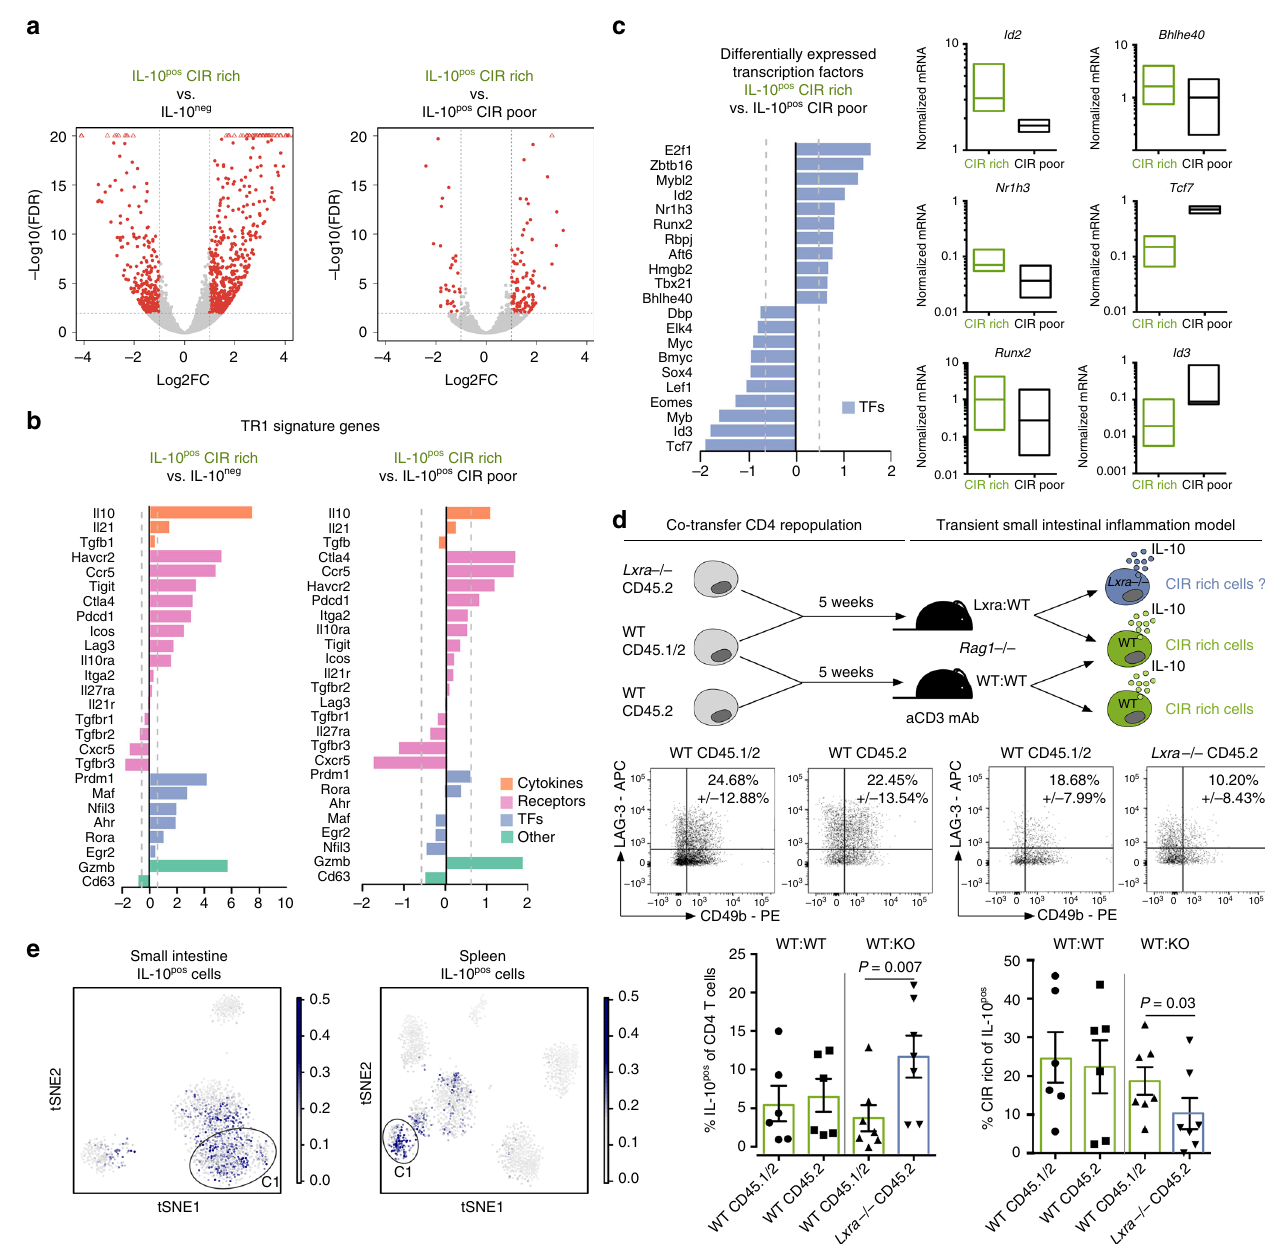
Fig. 5 CIR rich CD4 + T cells have a distinct transcriptional program. a Volcano plots of bulk RNA sequencing data of indicated populations (IL-10 pos CIR rich n = 2; IL-10 pos CIR poor n = 2; IL-10 neg n = 2). b Expression of known T R 1 signature genes comparing IL-10 pos CIR rich with IL-10 neg and IL-10 pos CIR rich with IL-10 pos CIR poor. c Differentially expressed transcription factors between IL-10 pos CIR rich and IL-10 pos CIR poor. mRNA expression of indicated genes normalized to Hprt from at least three independent experiments (separated low-high, line represents median). d CD4 + T cells isolated from Lxr α -/- CD45.2 and wildtype CD45.2 mice were co-transferred with wildtype CD4 + T cells (CD45.1/2) into lymphopenic hosts. Animals (WT:KO n = 7; WT:WT n = 6) were treated with aCD3 antibodies 5 weeks upon transfer and cells were isolated from small intestine. Results are cumulative of two independent experiments. A Wilcoxon test was used to calculate signi fi cance. e Correlation between genes signi fi cantly higher expressed in IL-10 pos CIR rich versus IL- 10 pos CIR poor cells and expression pattern of scRNA-seq